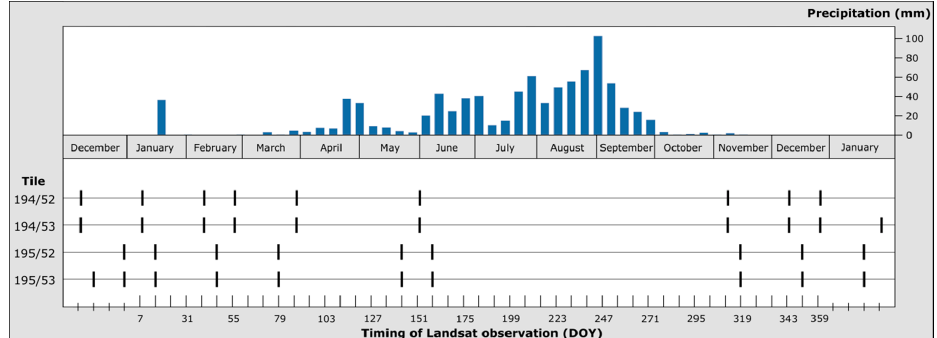
Figure 2. Overview of Landsat data used in this study distributed over four tiles for the period December 2013 to January 2015. Upper part shows the weekly precipitation sums over the year 2014 averaged over three rainfall stations in the study area [23,24].